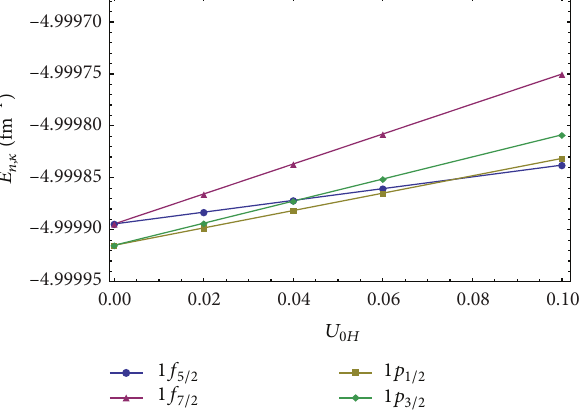
Figure 2: Contribution of the tensor Hulth´en potential parameter to the energy levels in the case of spin symmetry.